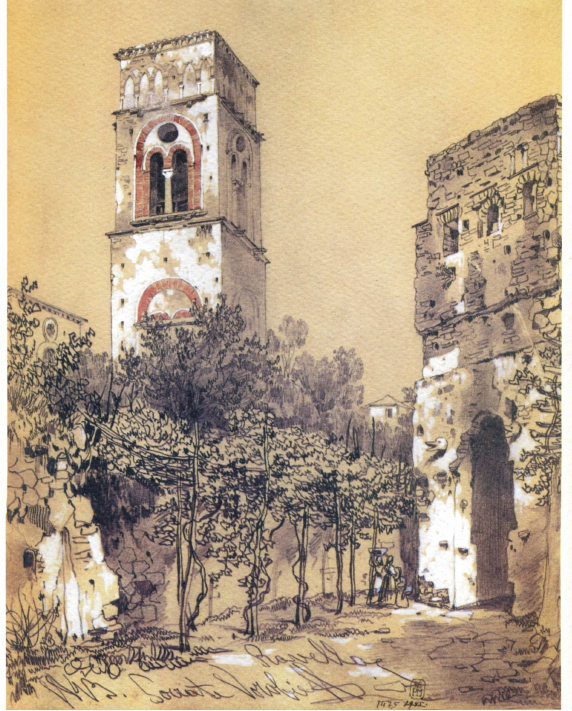
Figure 2. S. M. VOROb’eV, Ravello - watercolor of